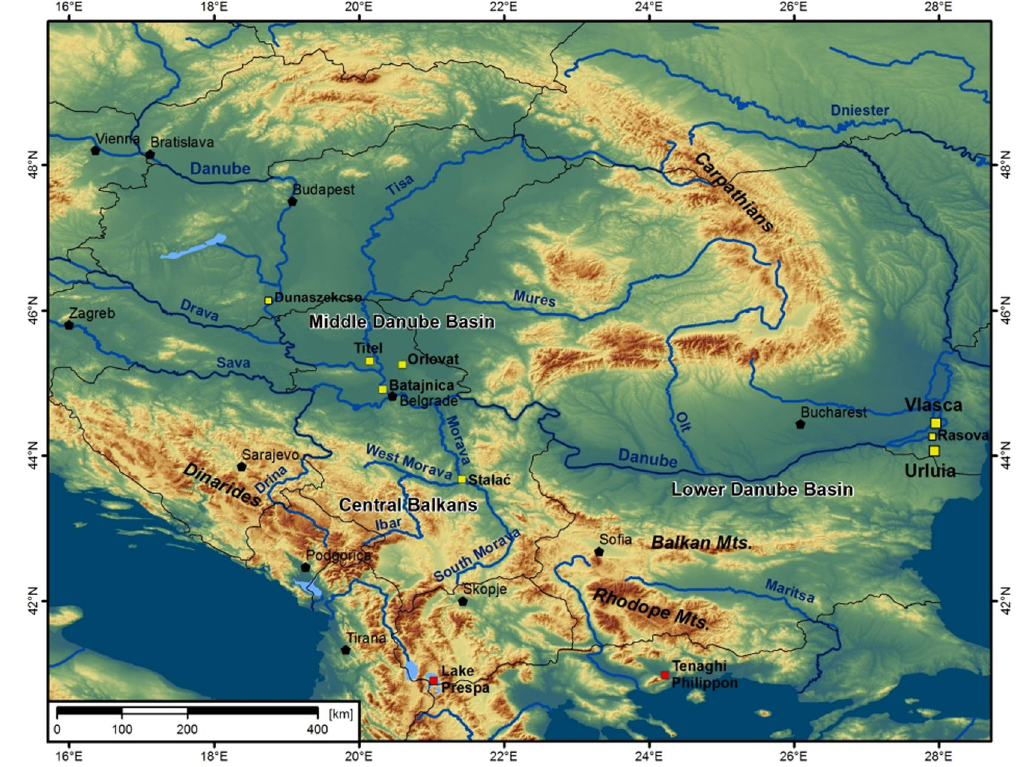
Figure 1. Map of the Southeastern Europe showing key loess-palaeosol sequences (Urluia (this study), Vlasca (this study), Rasova 12 , Titel 37, 40 , Batajnica 5, 11 , Orlovat 7 , Stalać 2 , Dunaszekcső 9 ) and lacustrine records (Lake Prespa 3 and Tenaghi Pilippon 42 ) discussed in this paper. The map was generated using ArcGIS 10.2.2 (http://